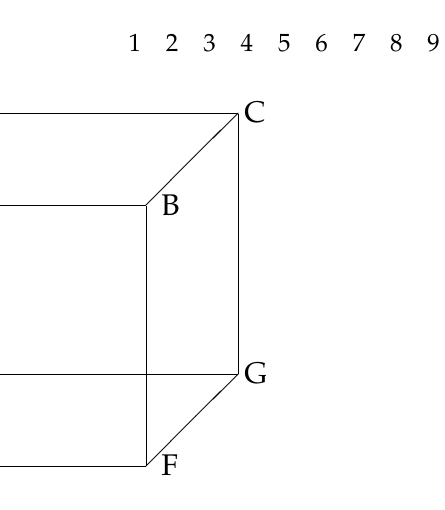
Figure 1. A Integer